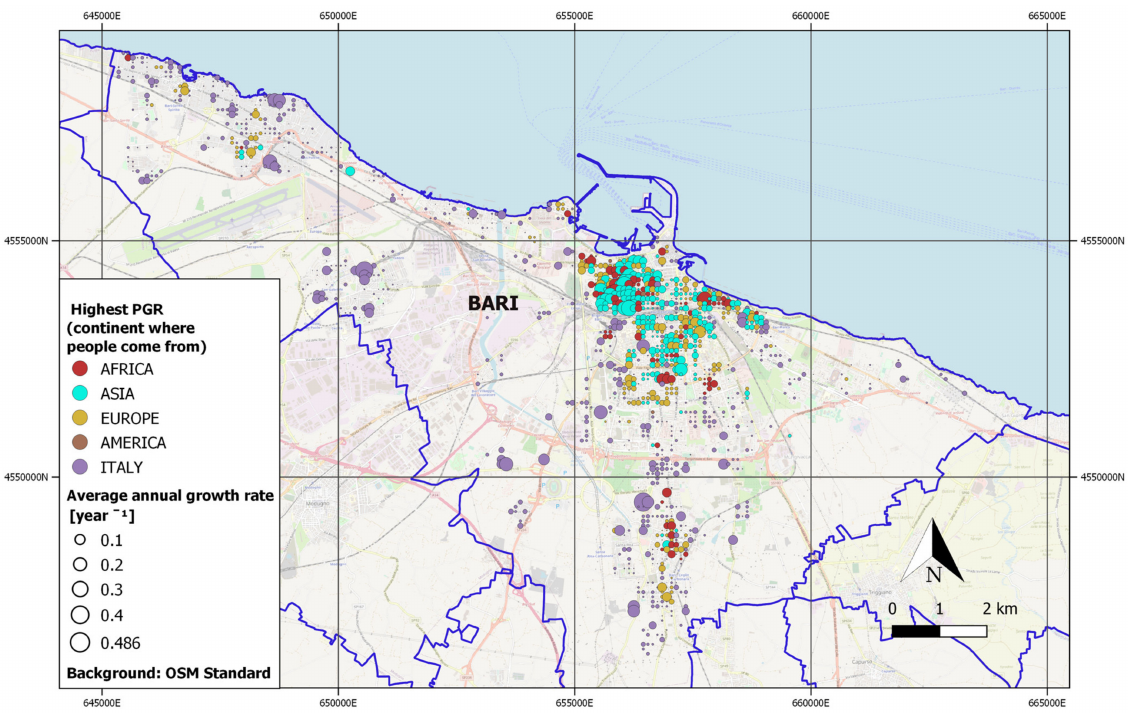
Figure 5. Migrant fluxes in Bari: spatial distribution and average annual population-growth rate (PGR) from 2011 to 2020. Reprinted with permission from